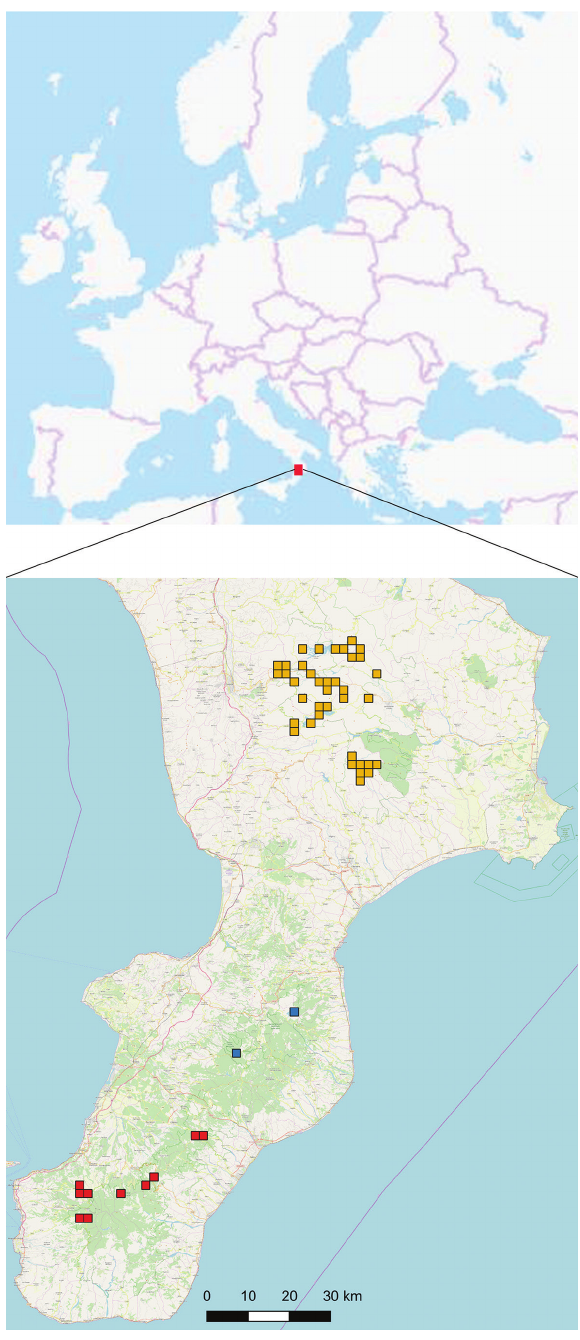
Figure 4. Position of the study area in the European context (upper side), and location of the Italian populations of Genista anglica (lower side). Brown squares, localities in Sila; blue squares, localities in Serre Calabre; red squares, localities in